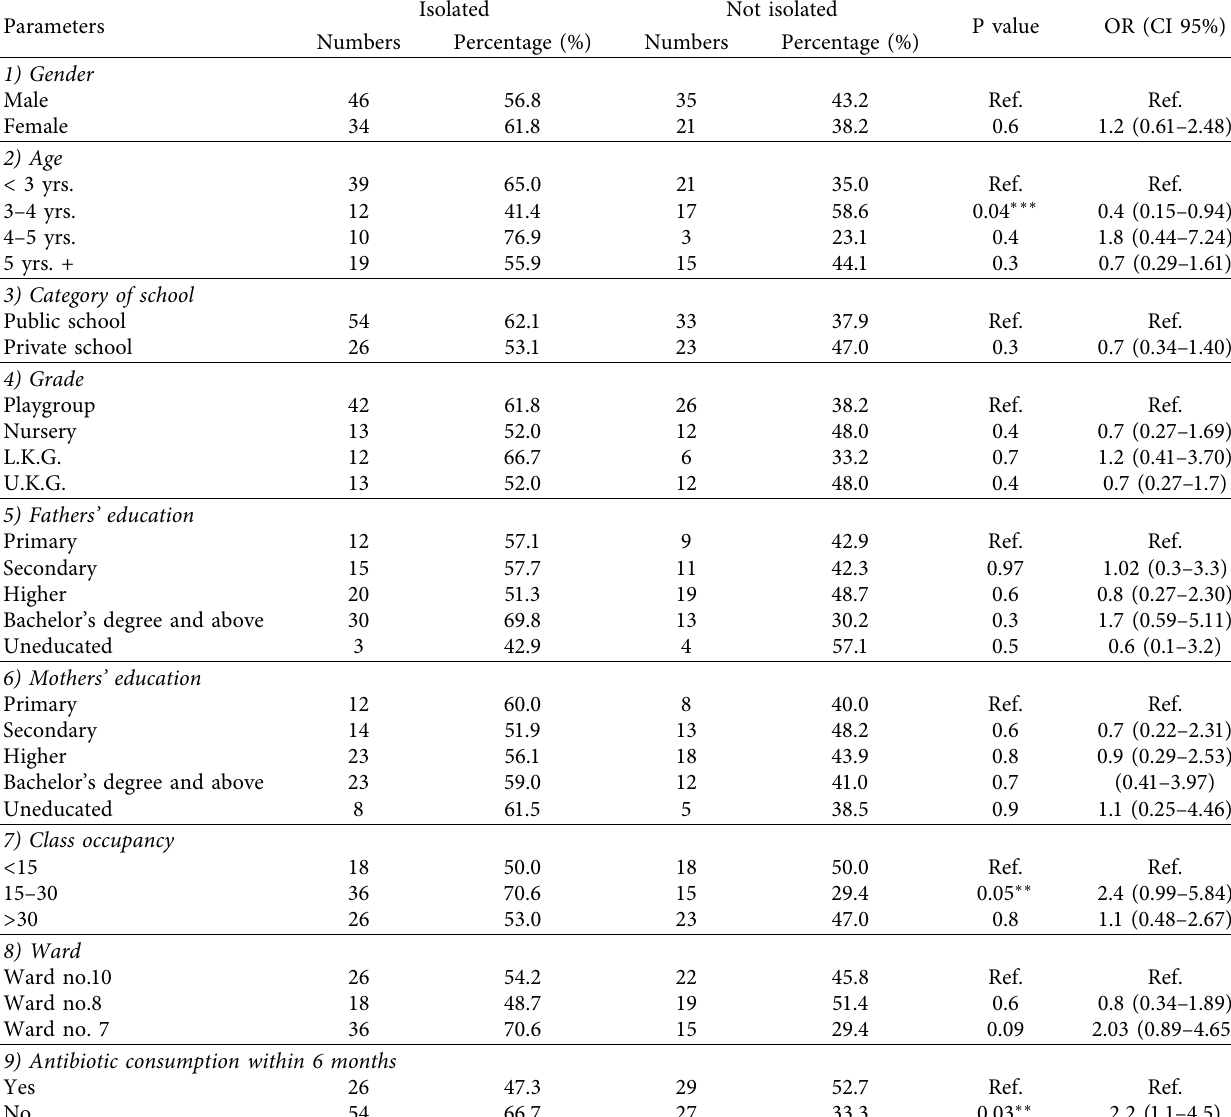
Table 3: Bivariate and multivariate analysis of risk factors for carriage of M. catarrhalis among participants. Parameters